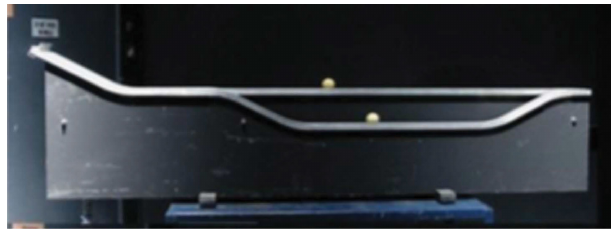
FIG. 5. Images of two tracks in the high road, low road demonstration.